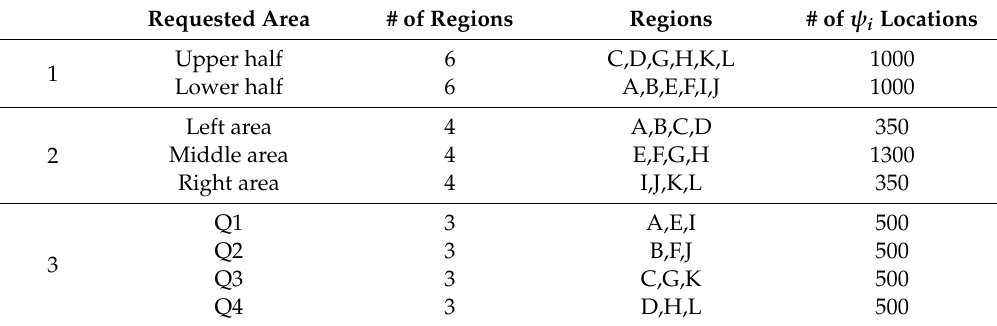
Figure 7. Graphical comparison between published and proposed heuristic. Table 9. Number of locations according to regions classification.